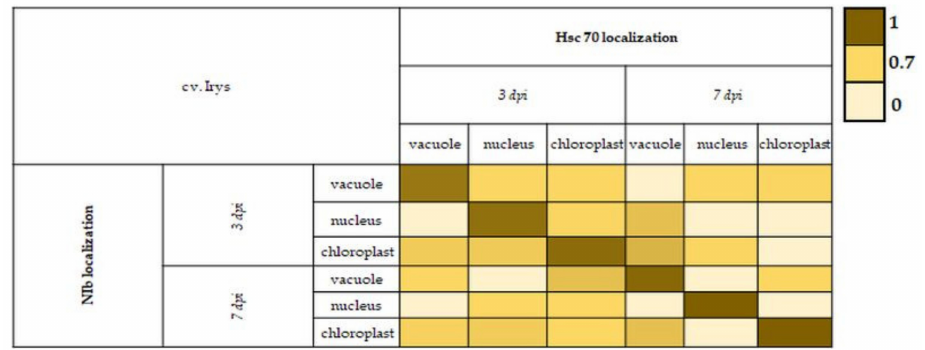
Figure 12. Heatmap of PCC for NIb and HSC70 localization in virus-inoculated Irys from 3 to 7 dpi. PCC matrix values are presented pairwise for specific cell compartments in specific time dpi and marked with colors, from very dark yellow (PCC = 1) to bright yellow (PCC = 0).